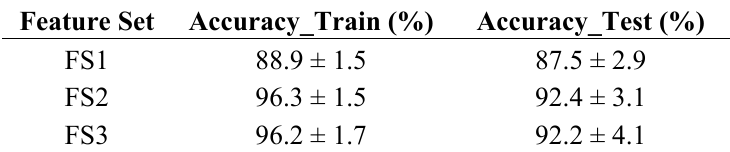
Table 7. System performance of the pseudo-two-class classification results.